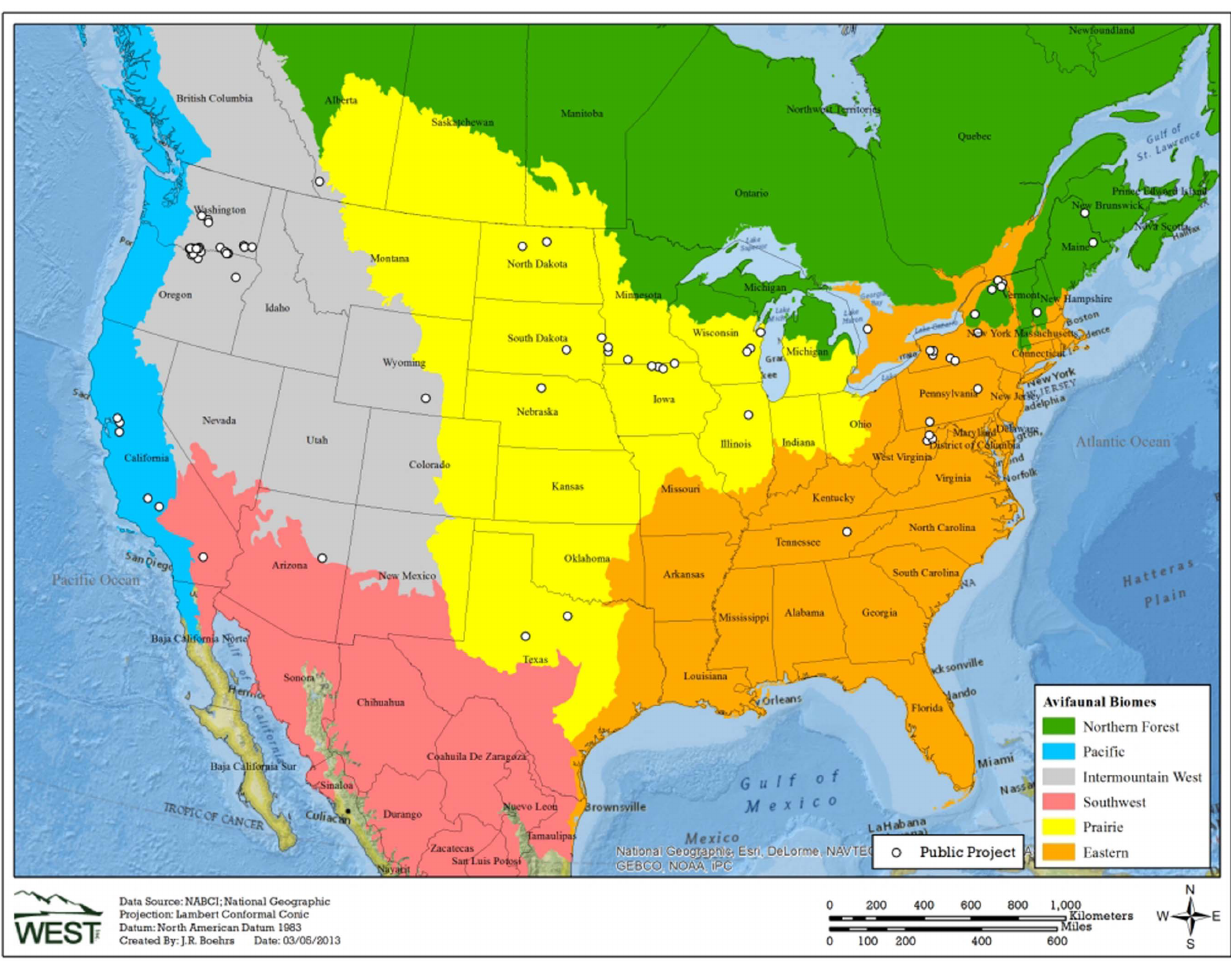
Figure 1. Locations of studies included for analysis of small-bird fatalities at wind energy facilities. The locations of wind energy facilities associated with 116 studies that were appropriate for inclusion in an analysis of fatalities of small passerines due to collisions with wind turbines. See details of studies in Appendix S1. Biomes adapted from Rich et al. [19] [58] [59] [60].